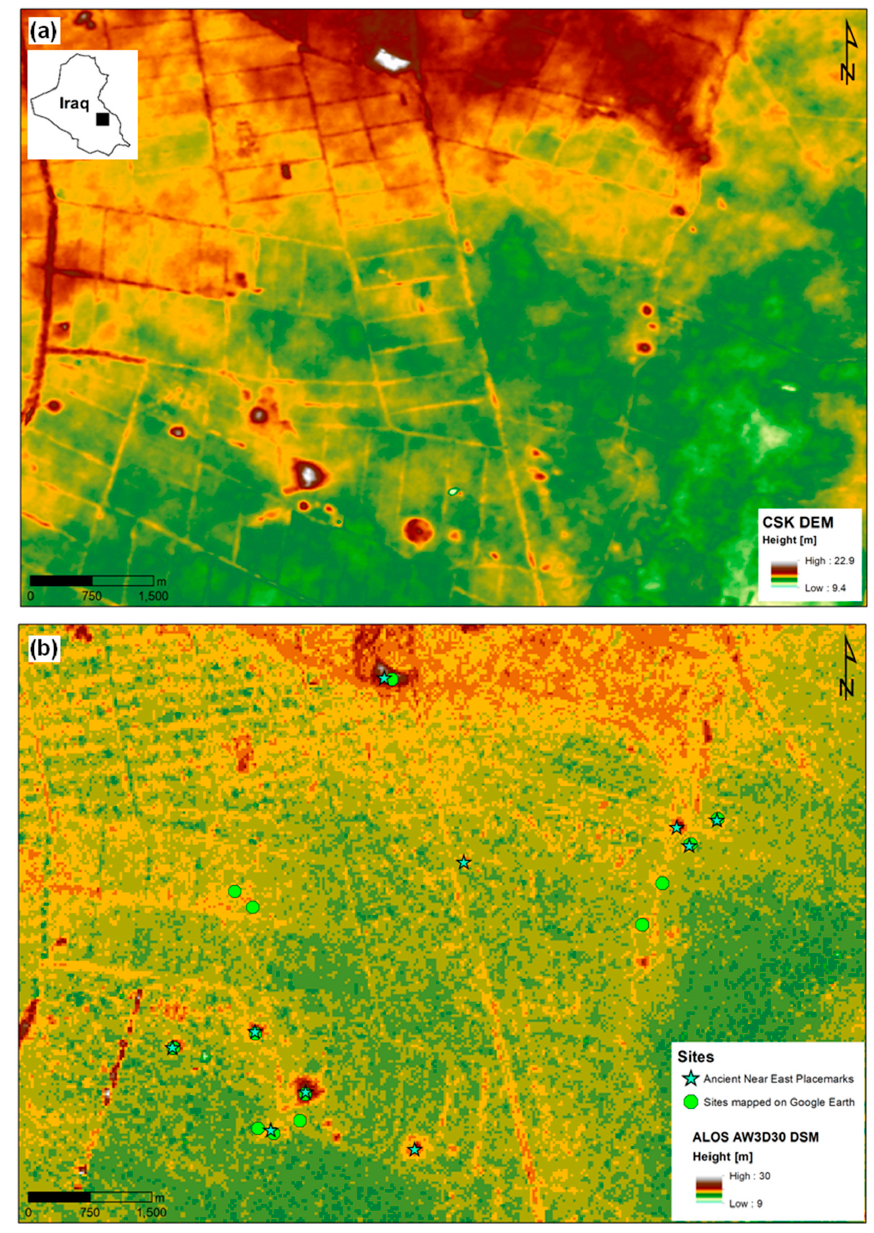
Figure 5. Comparison of ( a ) high resolution DEM obtained from a tandem pair of COSMO-SkyMed StripMap Himage scenes acquired at 3 m spatial resolution in May 2018, and ( b ) 30-m resolution ALOS Global Digital Surface Model (AW3D30 DSM) over a study area within the Wasit region in Iraq. The COSMO-SkyMed DEM highlights the presence of archaeological tells that match with the “Ancient Near East placemarks” mapped by Pedersén [45] and the sites identified by the authors on Google Earth. Other rounded patterns are clearly observed and can represent remnants of unmapped tells. COSMO-SkyMed® Product ©ASI—Italian Space Agency—2018. All Rights Reserved.